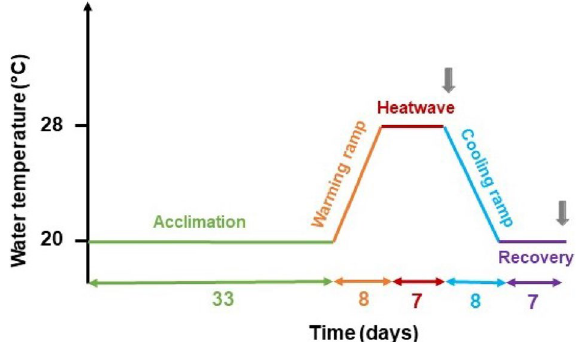
Figure 6. Scheme of the experimental schedule. Water temperature as a function of time. Acclimation , warming ramp , heatwave , cooling ramp , recovery, and respective duration on the x-axis (in days). Grey arrows indicate the two sampling